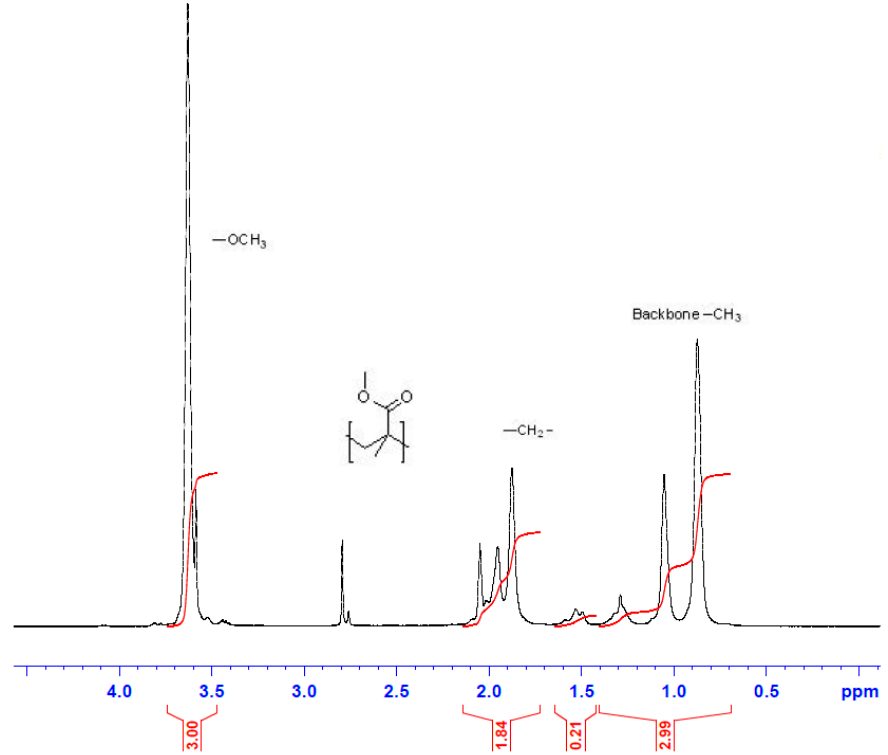
Figure 8. NMR spectrometry: image of final polymer product of the E2 run for a sample collected after 3 h of polymerization.